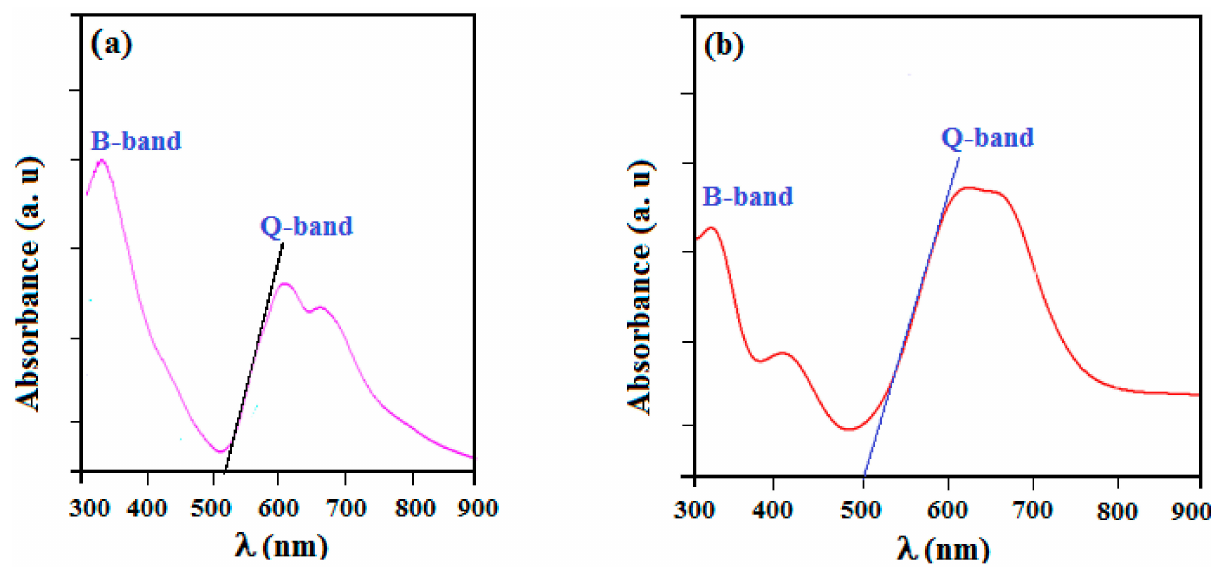
Figure 7. Electronic absorption spectra of PdPc(Im) 4 in DMSO solution (10 − 5 M) ( a ) and ( b ) thin- film